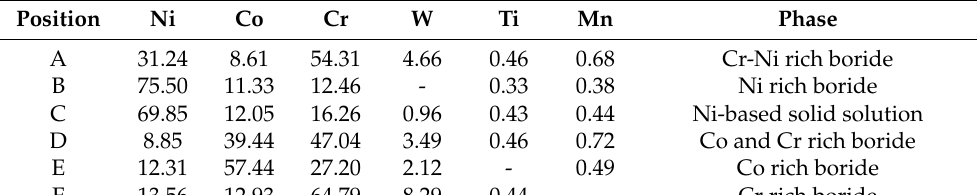
Table 3. EDS chemical analysis (at.%) of different positions in Figure 4.